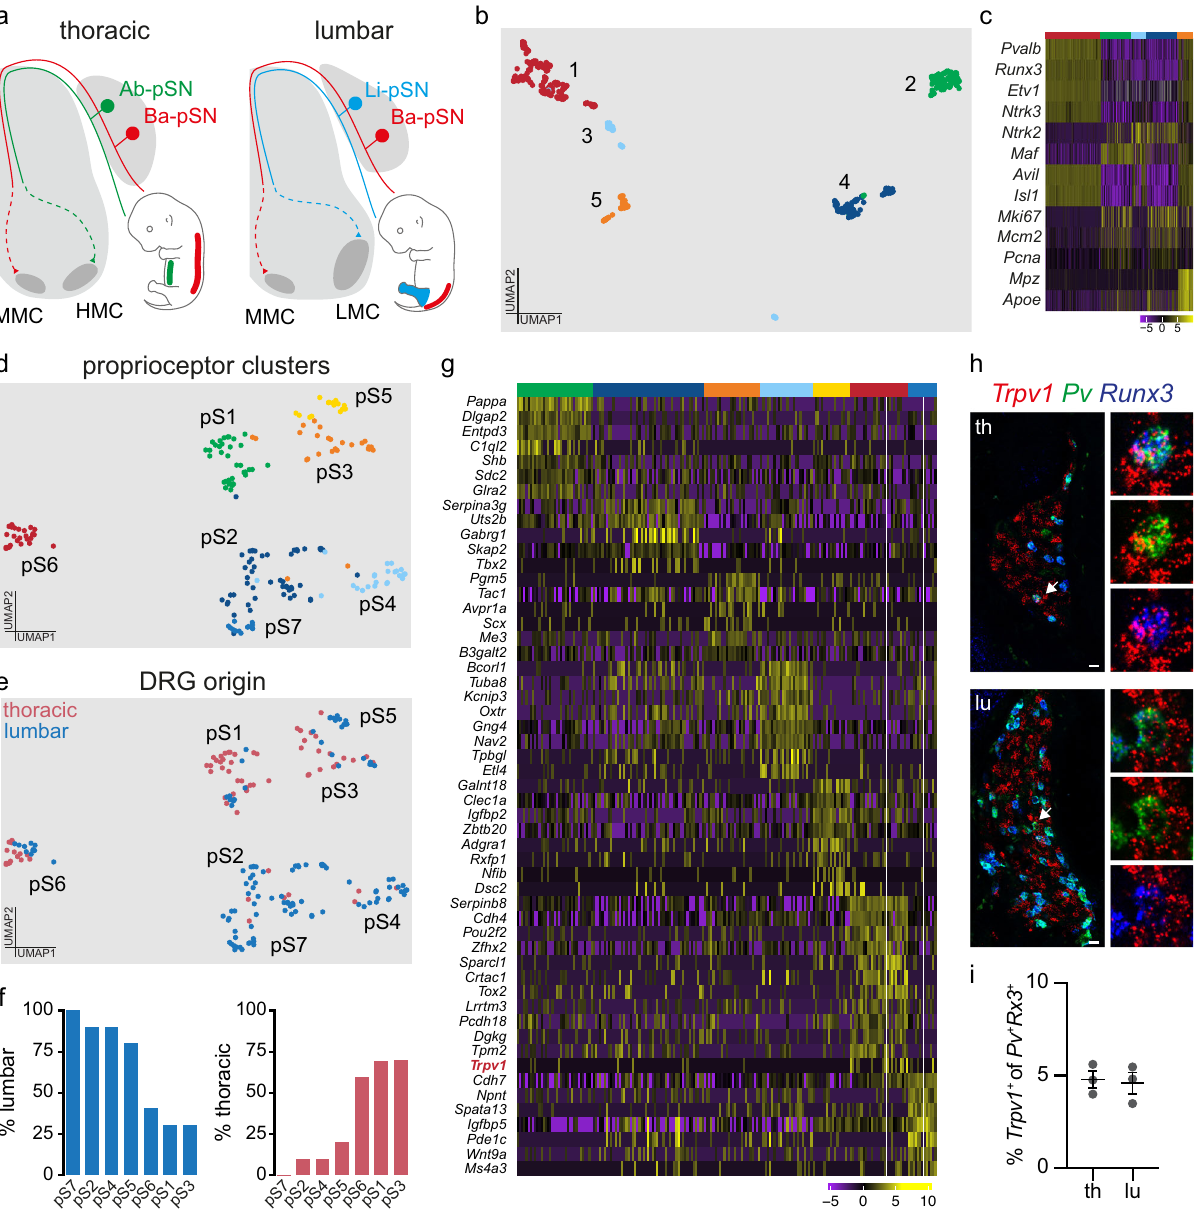
Fig. 1 | Single-cell transcriptome analysis of thoracic and lumbar propriocep- tors at e15.5. a Schematic illustrating central and peripheral connectivity of e15.5 proprioceptors at thoracic (left) and lumbar (right) spinal levels. Ab-pSN, abdom- inal muscles-connecting proprioceptors; Ba-pSN, back muscles-connecting pro- prioceptors; Li-pSN, hindlimb muscles-connecting proprioceptors; MMC, median motorcolumn;HMC,hypaxialmotorcolumn;LMC,lateralmotorcolumn. b UMAP visualization of tdTomato + neuron clusters from Pv tdTom embryos at e15.5. c Gene expression analysis (logcounts) of proprioceptors ( Pv , Runx3 , Etv1 , Ntrk3 ), mechanoreceptors ( Ntrk2 , Maf) , postmitotic neurons ( Avil , Isl1 ), proliferating neu- rons ( Mki67 , Mcm2 , Pcna ) and glial ( Mpz , Apoe ) markers. d UMAP visualization of proprioceptorclustersidenti fi edfromanalysisofcluster1. e UMAPvisualizationof